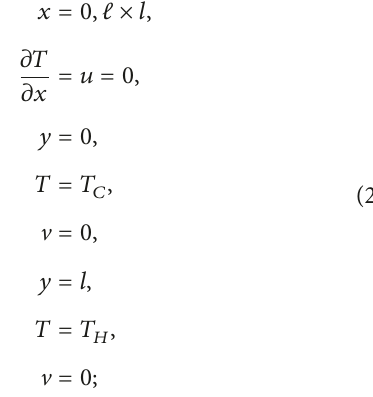
the gravity acceleration and 𝑏(𝑡) = 𝜆 1 sin ( ] 1 𝑡) + 𝜆 2 sin ( ] 2 𝑡)